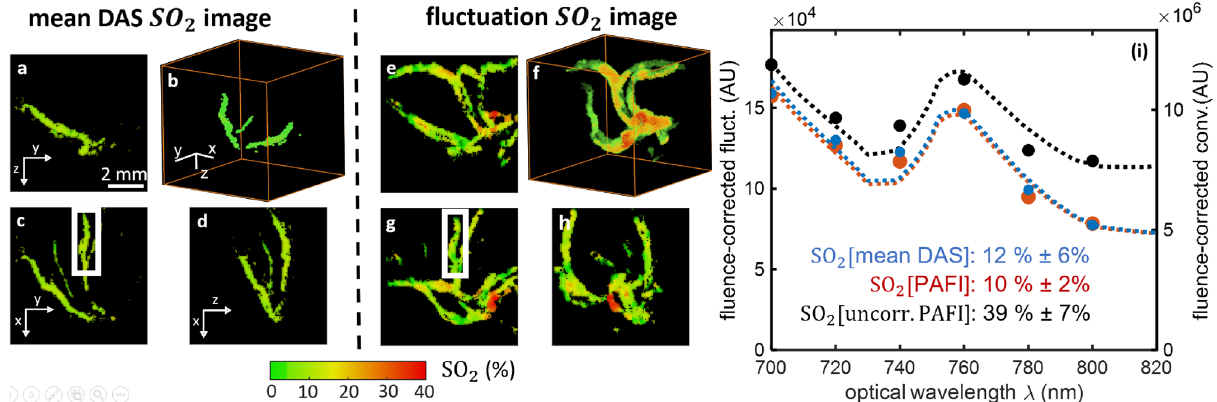
Figure 4. Three-dimensional quantitative SO 2 imaging in chicken embryo. ( a–d ) Visibility-limited SO 2 images obtained from conventional DAS multispectral photoacoustic imaging. ( e–h ) Full-visibility SO 2 images obtained from MS-PAFI. 2D images are maximum intensity projections through 3D data. ( i ) Relative spectral dependence of µ RBC ( (cid:31) , r ) estimated over the rectangular region of interest (ROI): blue, red and black estimates are respectively for DAS imaging, PAFI and uncorrected PAFI (without noise subtraction). ± values for SO 2 are the spatial standard deviation computed over the ROI.